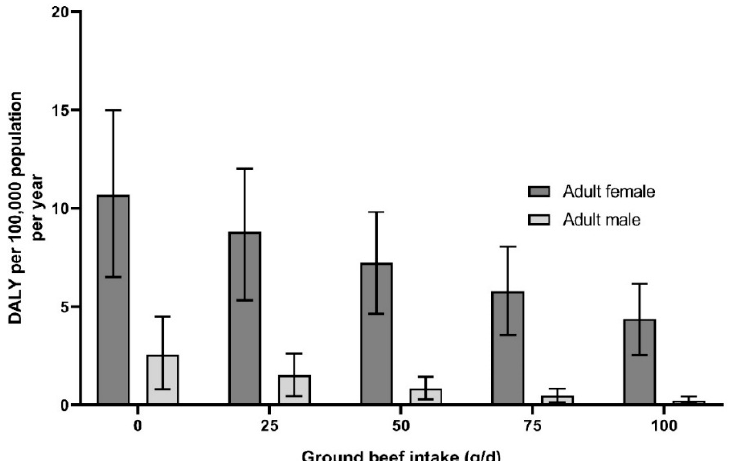
Figure 3. Estimated number of DALY from iron deficiency anemias in France for adult males and females according to ground beef consumption scenarios. Results expressed per 100,000 individuals per year. Full lines represent the 95% uncertainty around the mean value.